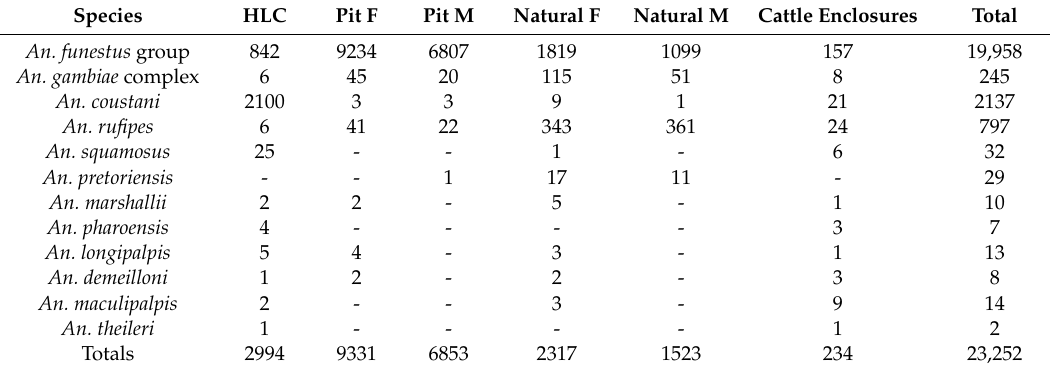
Table 5. Anopheles mosquitoes collected from Thomo village, Limpopo Province, from June 1987 to August 1989 [14]. F = females; M = males; HLC = human landing catches; Pit = pit collections; Natural = natural